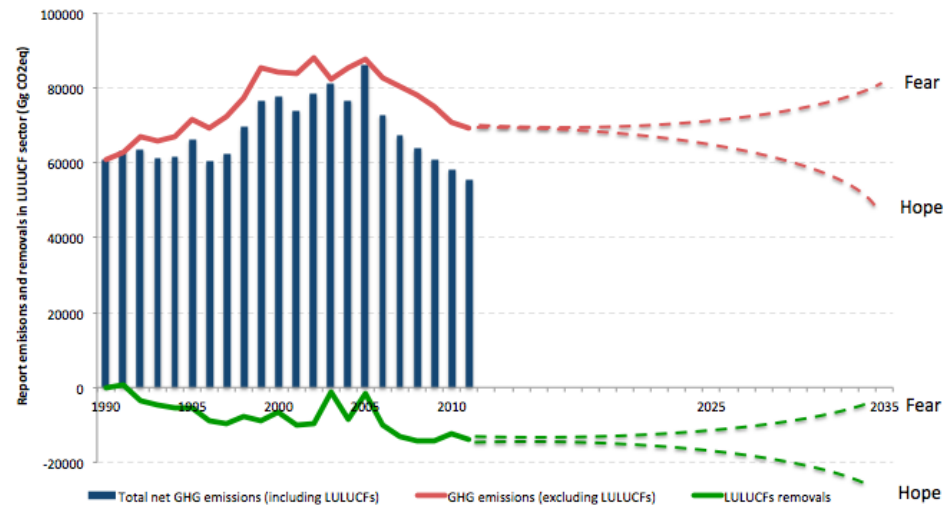
Fig. 2. Climate regulation reference mode (Data from [26]; “Hopes and fears” pathways adapted from the approach proposed by [27]). Total emissions (excluding LULUCF’s) include several sectors, such as energy production, industrial processes, solvents and use of other products, agriculture and waste. The emissions are represented in CO 2 eq and include carbon dioxide, methane, nitrous oxide and fluorinated